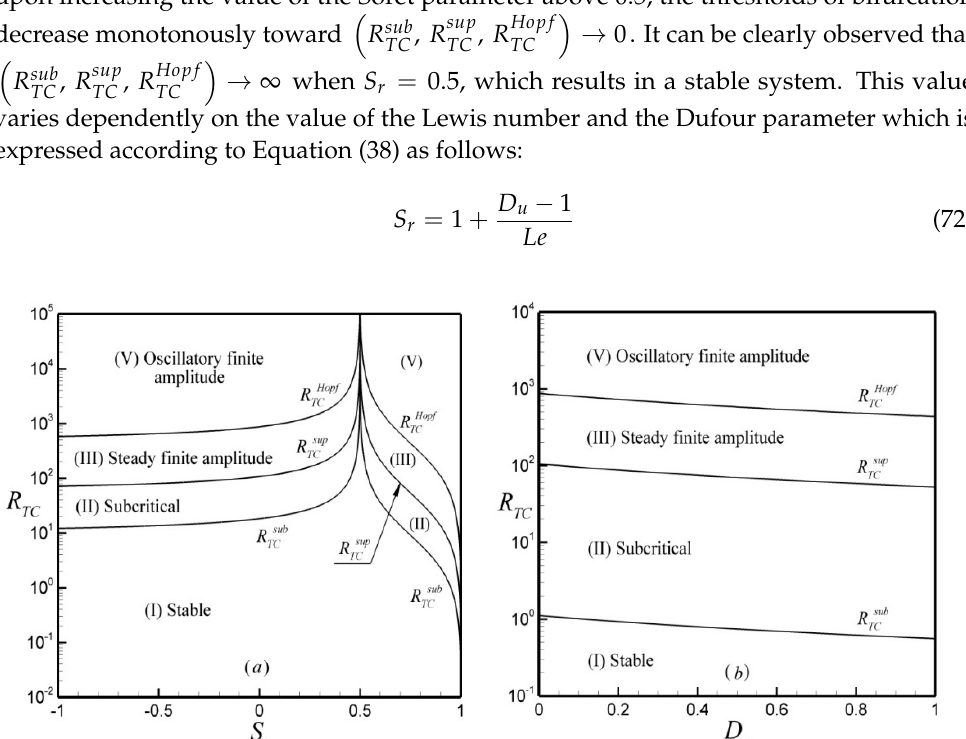
, R sup , R Hopf as functions of ( a ) Soret parameter S r ( D u = 0 ) TC TC TC